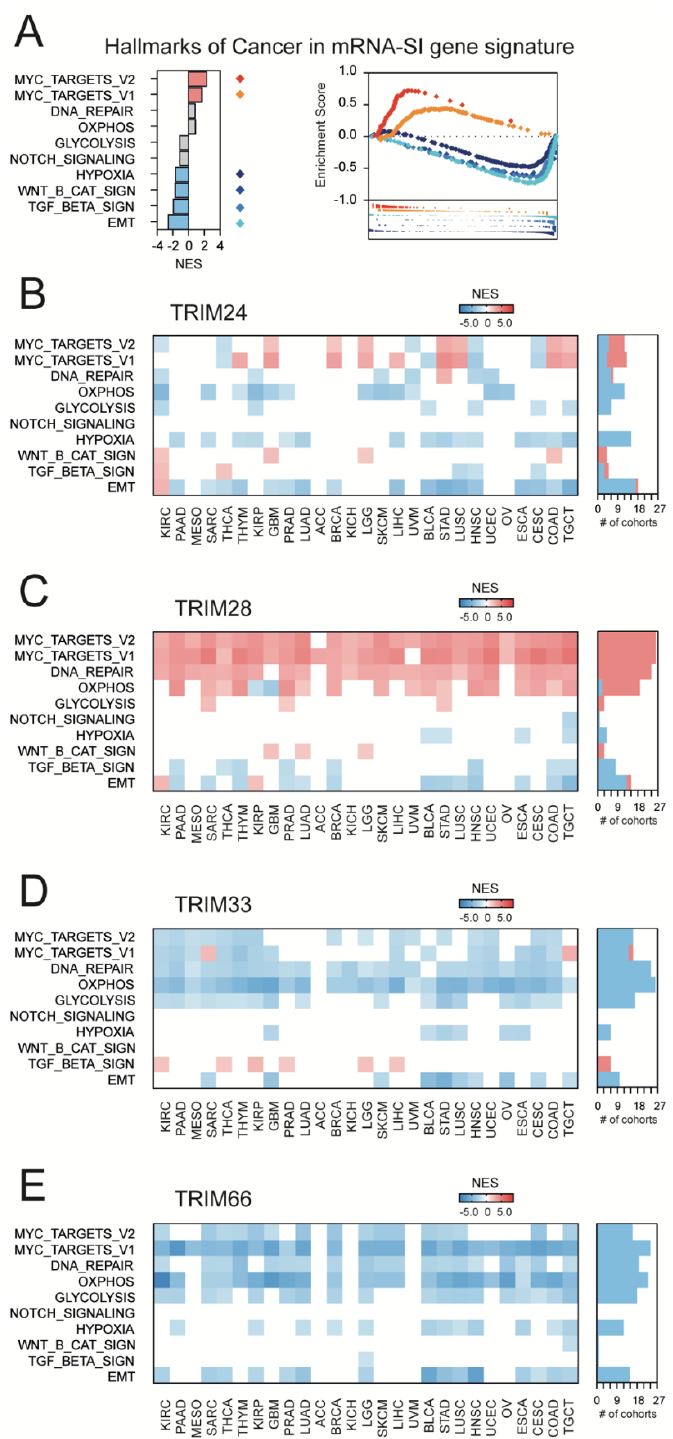
Figure 4. The hallmarks of cancer in mRNA ‐ SI and TIF1 ‐ associated gene signatures. ( A ) The targets for c ‐ Myc transcription factors are enriched, while the genes associated with hypoxia, Wnt/ β‐ catenin signaling, Tumor Growth Factor ‐β (TGF ‐β ) signaling, and Epithelial ‐ Mesenchymal Transition (EMT) are depleted in the mRNA ‐ SI gene signature. NES – Normalized Enrichment Score. Red — enriched terms; blue — depleted terms; grey — no statistical significance (FDR >1%). ( B–E ) The transcriptome profiles associated with TRIM24 ( B ), TRIM28 ( C ), TRIM33 ( D ), or TRIM66 ( E ) gene expression are differentially enriched or depleted with hallmarks of cancer terms, and TRIM28 ‐ associated transcriptome profiles are consequently enriched, while TRIM66 ‐ associated transcriptome profiles are consequently depleted with the targets for c ‐ Myc transcription factor.